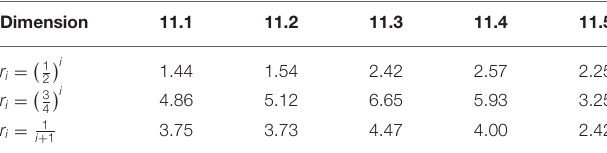
TABLE 5 | Capabilities for dimension 11 “ICT connectivity ” with decreasing effort (cutting edges in the beginning). Dimension 11.1